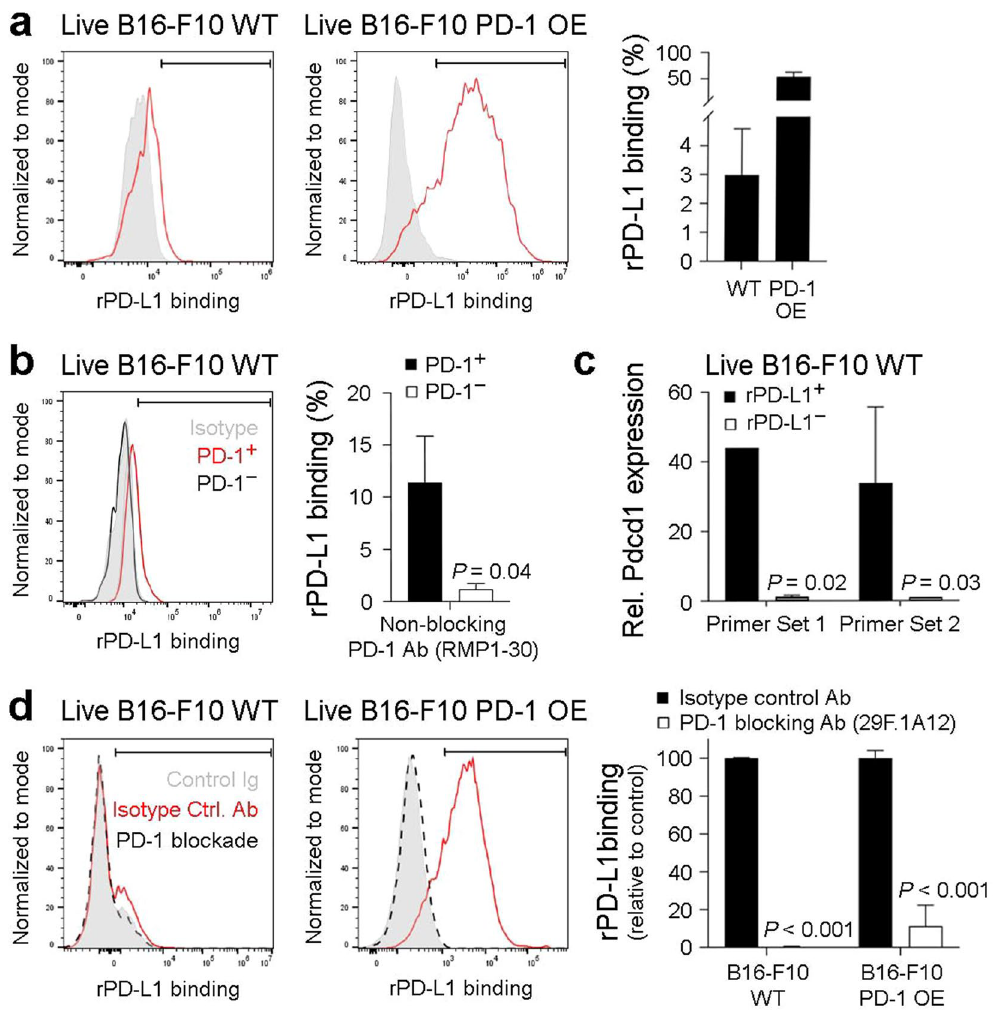
Figure 6. The 29F.1A12 anti-PD-1 monoclonal antibody blocks PD-1 interactions with recombinant PD-L1 on live B16-F10 melanoma cells. ( a,b ) Representative histograms (left) and % recombinant (r)PD-L1 binding (mean ± s.e.m., right), to live (FVD − ) ( a ) B16-F10 wild-type (WT) or PD-1-overexpressing (OE) melanoma cells or ( b ) PD-1 + (red line) versus PD-1 − (black line), RMP1-30-gated B16-F10 WT melanoma cell subset. ( c ) Relative Pdcd1 expression (mean ± s.d., two distinct primer sets), as determined by real-time qPCR, in live (FVD − ) FACS-sorted, rPD-L1 +/− B16-F10 WT subpopulations. ( d ) Effect of antibody-mediated PD-1 blockade (29F.1A12, black dashed line) versus isotype control (red line) on rPD-L1 binding to B16-F10 WT or PD-1 OE melanoma cells. Shown are representative histogram plots (left) and % rPD-L1 relative to isotype control (mean ± s.e.m., right). Results are representative of at least n = 3 independent experiments. * p < 0.01; *** p <